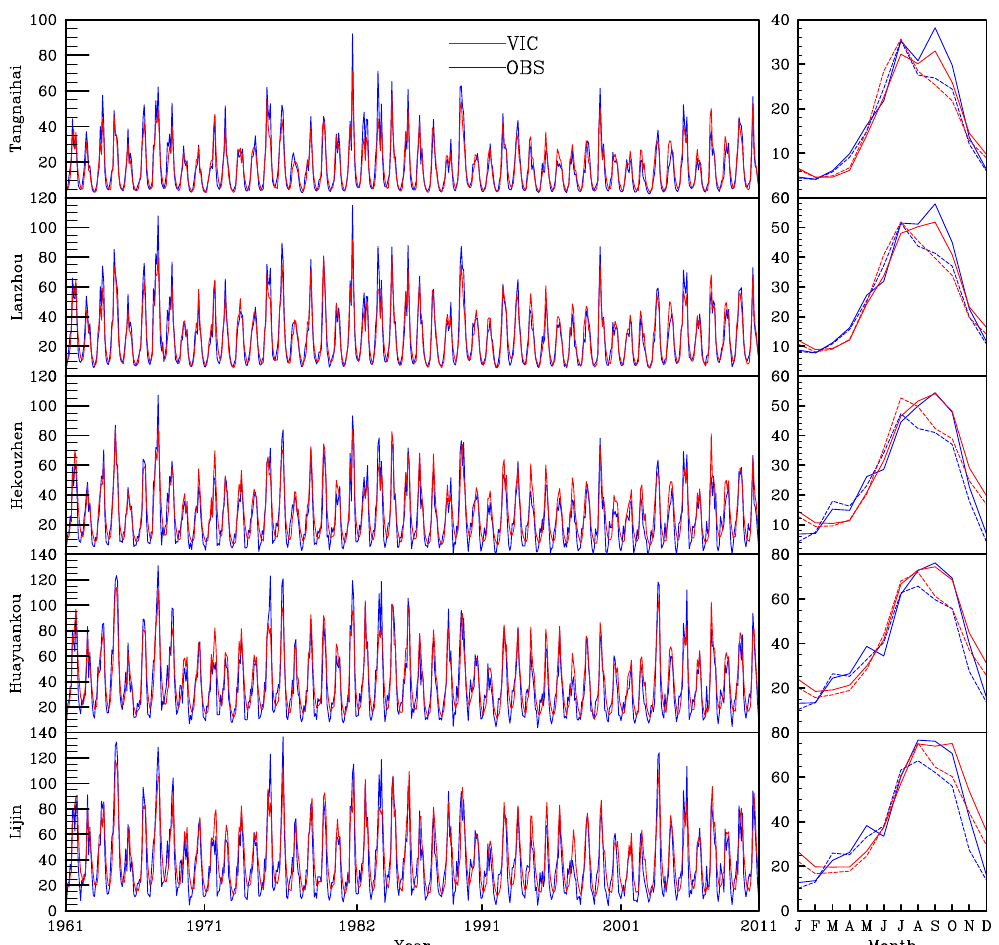
Figure 4. Naturalized (blue) and VIC-simulated (red) monthly streamflow (10 8 m 3 s − 1 ) at five hydrological gauges located from upper to lower mainstream of the Yellow River. The solid and dashed lines in the right panels represent the climatologies during the calibration (1961–1981) and validation (1982–2010)